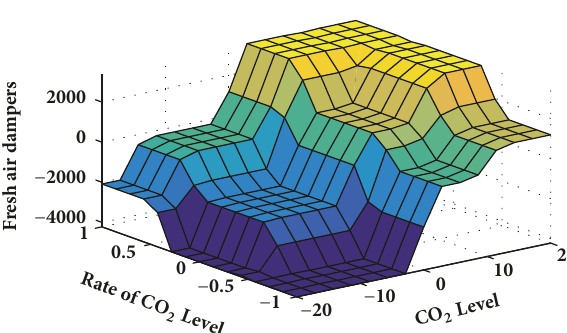
Figure 21: Control surface of the third output.